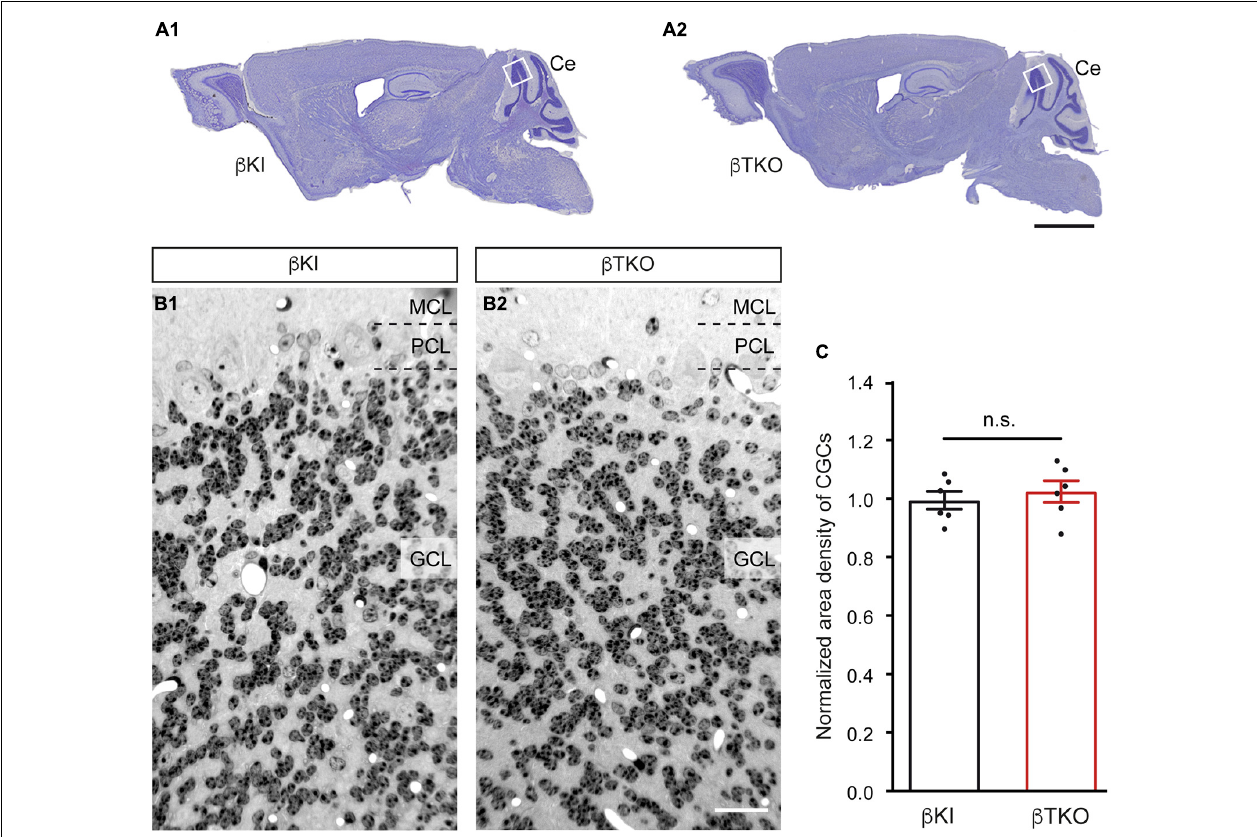
FIGURE 6 | Normal numbers of cerebellar granule cells (CGCs) in β -Nrxn-deficient mice. (A) Nissl-stained parasagittal sections through the brains of β -KI control (A 1 ) and β -Nrxn-deficient β -TKO (A 2 ) mice. Ce = cerebellum; box indicates approximate position of area investigated in panels (B,C) . Scale bar: 2 mm. (B) Representative images of 1- µ m semithin sections from β -KI control (B 1 ) and β -Nrxn-deficient β -TKO (B 2 ) cerebellum stained with toluidine blue dye.